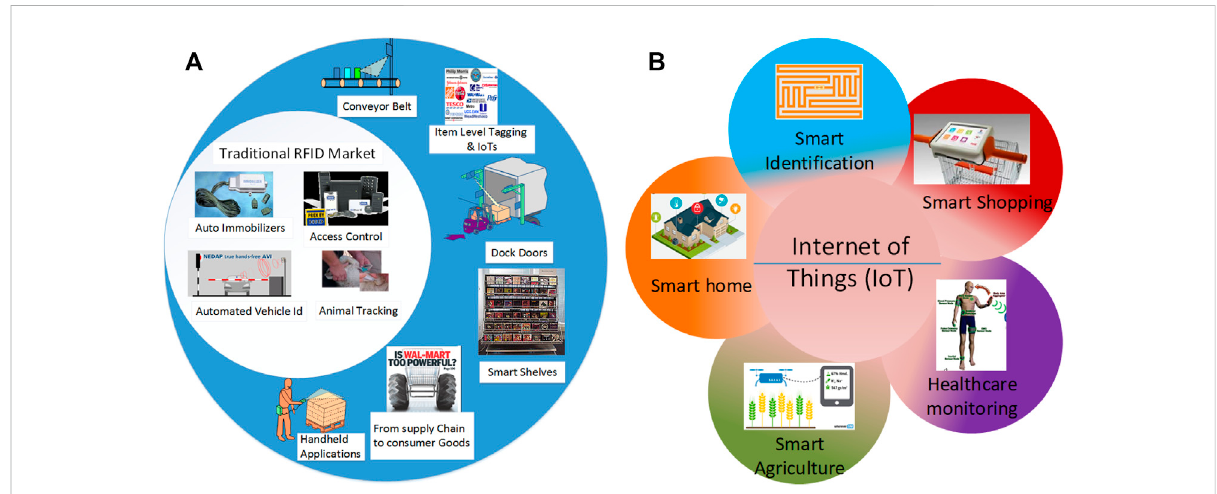
FIGURE 2 Paradigm shift of RFID applications. (A) From traditional to modern applications. (B) Promising application areas of IoT overlapping with